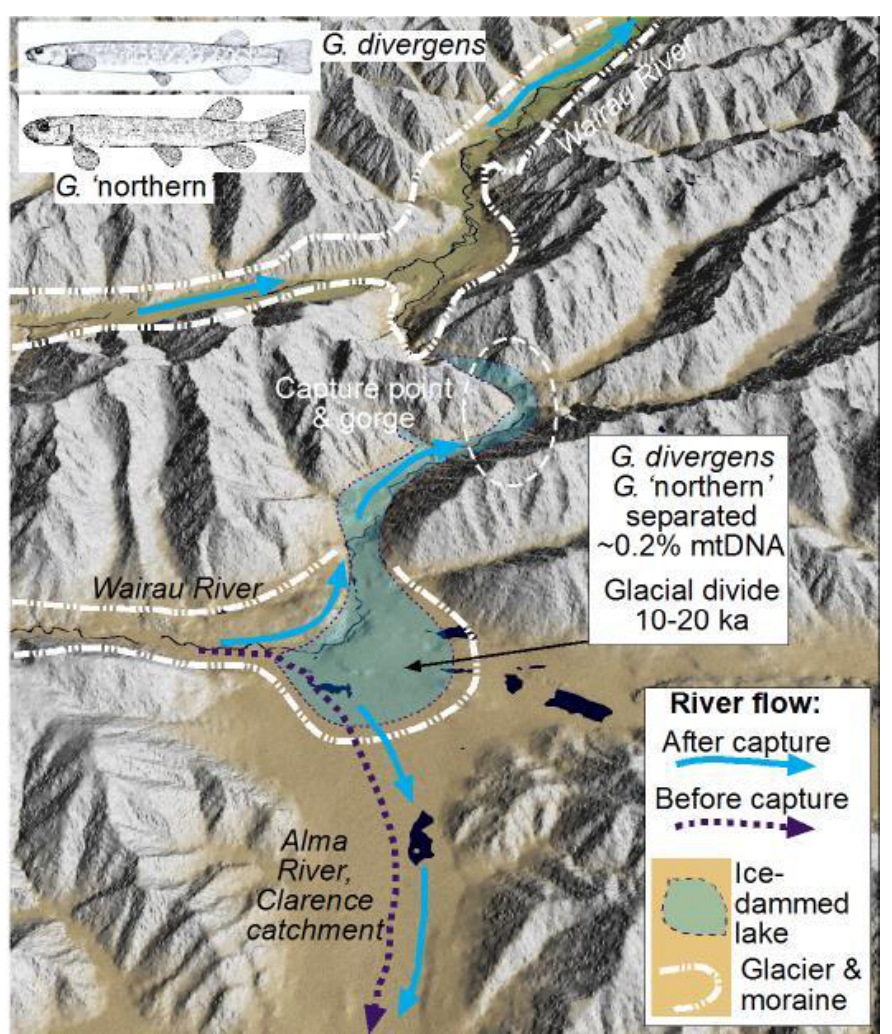
Figure 7. Headwaters of two major drainages in inland Marlborough, the Wairau and Clarence Rivers (Figure 1), were linked by glaciers and a glacial lake during the late Pleistocene. These links facilitated genetic exchange among populations of two co-distributed Galaxias species ( G. divergens , G. vulgaris ‘northern’) until their populations were severed during the last glacial retreat. These headwater connections are highlighted by the similarity of Clarence and Wairau populations relative to those of the geographically intermediate Awatere River [12].